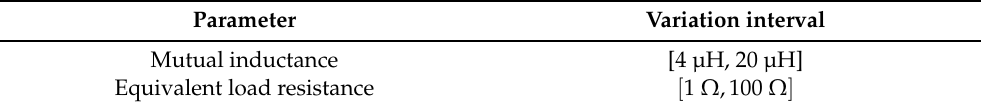
Table 8. The variation interval of L m and R L .